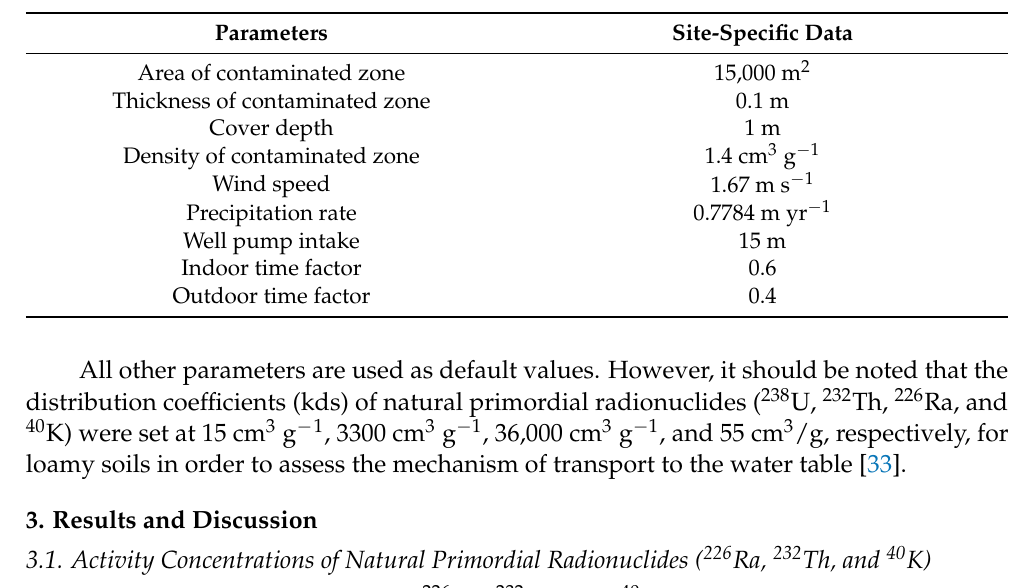
Table 2. Site-specific parameters of the study